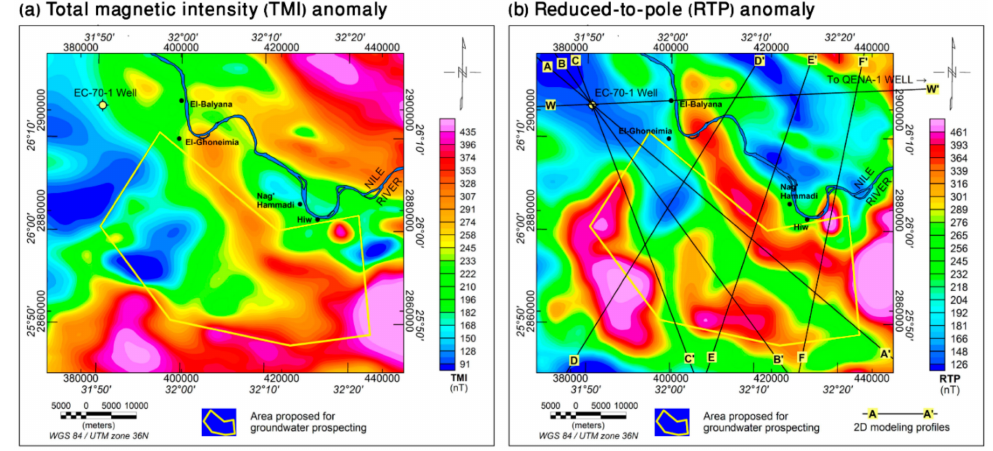
Figure 7. ( a ) Total magnetic intensity (TMI) anomaly map; ( b ) reduced-to-pole (RTP) anomaly map. The TMI data were processed in the wavenumber domain using the Oasis Montaj software